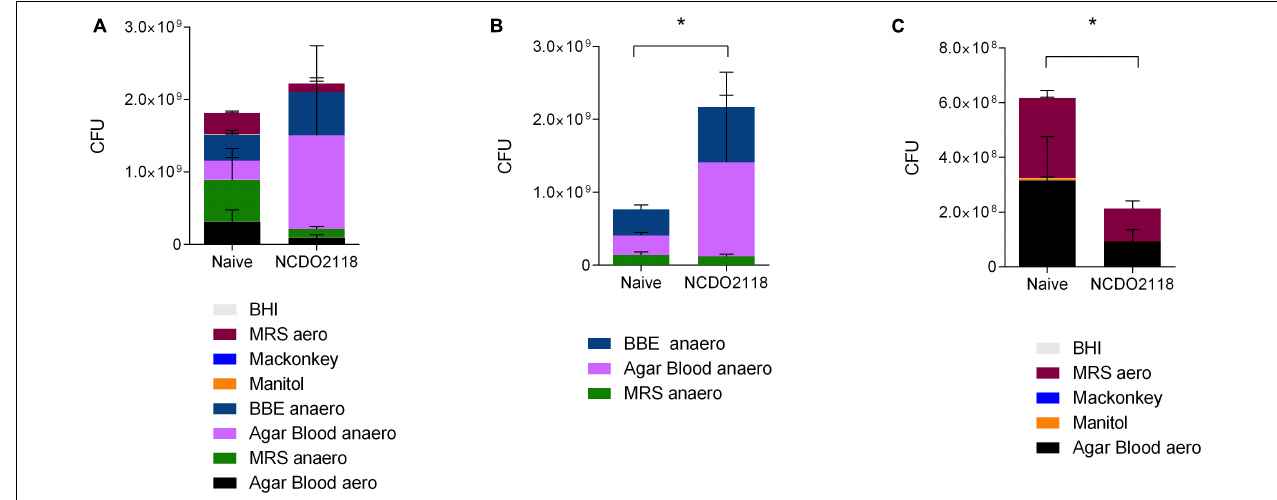
FIGURE 7 | Profile of the small intestine microbiota after L. lactis NCDO2118 administration. C57BL/6 mice received L. lactis NCDO2118 in the drinking bottle for 4 days. After euthanasia, the entire fecal content of the small intestine was collected and cultured in different media. Representative graphs showing the CFU grown either in all media (A) , in media maintained in anaerobiosis (B) , or in aerobiosis (C) for 24 h. Naive non-manipulated mice were used as control. Statistical significance of the difference between groups was calculated using the ANOVA test. Values represent the mean ± SEM. * p <